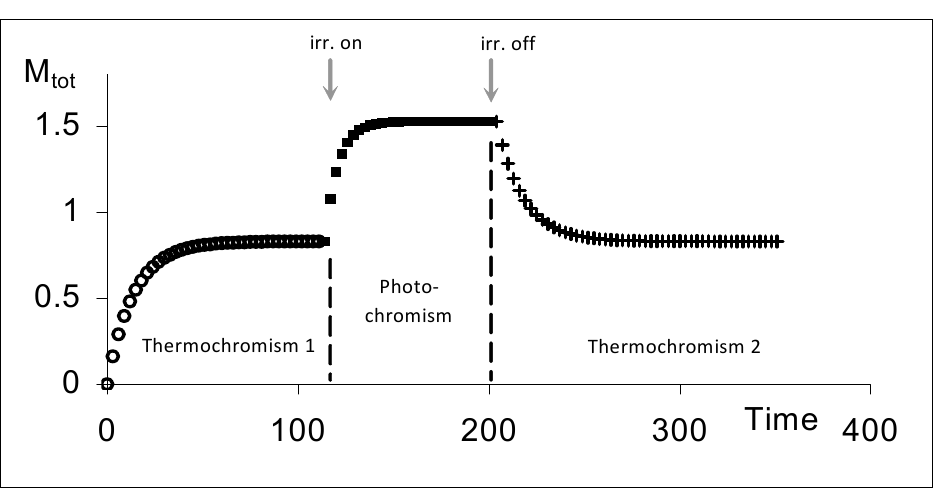
Figure 12 : Typical kinetic traces depicting the three successive phases (Th1 ( ο ), P ( (cid:131) ) and Th2 ( + )) of a thermophoto-reactive system (with M absorbance of the medium at the observation wavelength; irr. on and irr. off represent respectively the start and end of the isosbestic irradiation) [reprinted from Ref. 95 with permission of the International Journal of Chemical